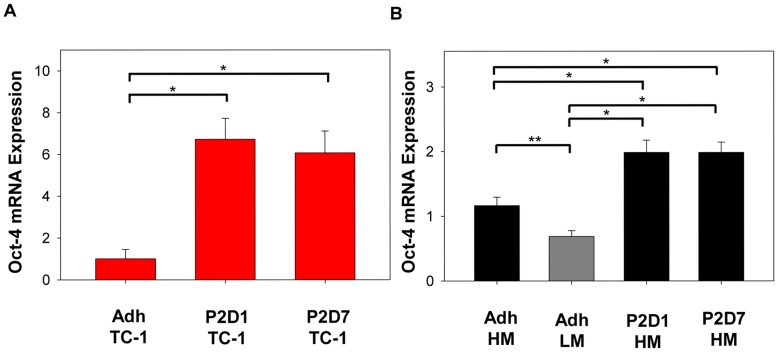
Oct-4 expression is increased in spheres compared to adherent cells.Real time PCR quantitation was done for Oct-4, a gene associated with stem cell self-renewal, mRNA expression. TC-1 spheres (A) and HM-LLC spheres (B) demonstrate increased Oct-4 expression compared to matched adherent cells; *P≤0.001. HM-LLC cells expressed significantly more Oct-4 than LM-LLC adherent cells; **P = 0.005. Plots represent combined data from 2–4 biological replicates, each with three technical replicates. TC-1 cells (red); LM-LLC adherent (grey); HM-LLC cells (black). Bars: ±SEM.